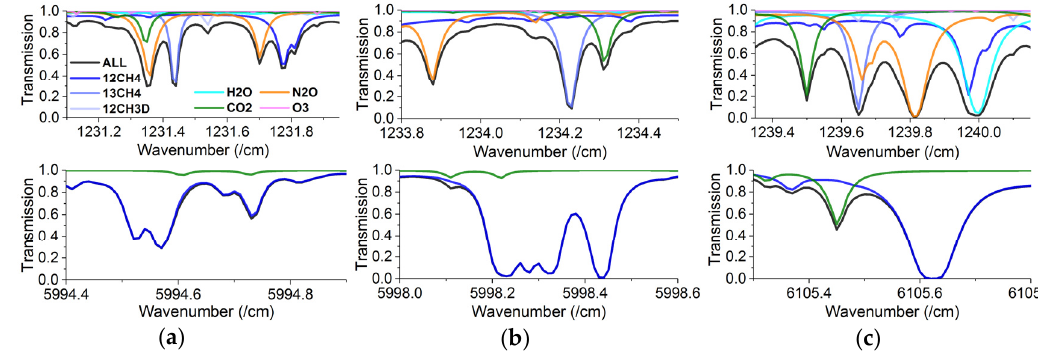
Figure 7. Three down-selected narrow spectral window pairs optimized for the MISO mission objectives, ( a ) centred at 5994.65 cm − 1 , ( b ) centred at 5998.30 cm − 1 , ( c ) centred 6105.60 cm − 1 . Top panels refer to the TIR HIROS and bottom panels to the SWIR LHR. Only 9 km tangent heights are shown.